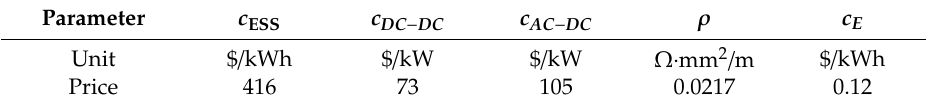
Table 8. Constant parameters used for economic